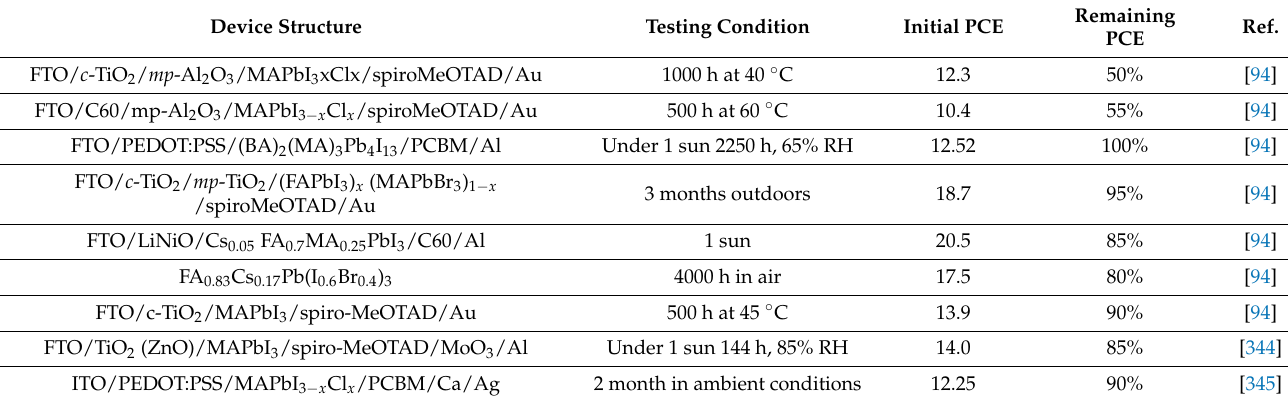
Table 1. Encapsulated devices along with their